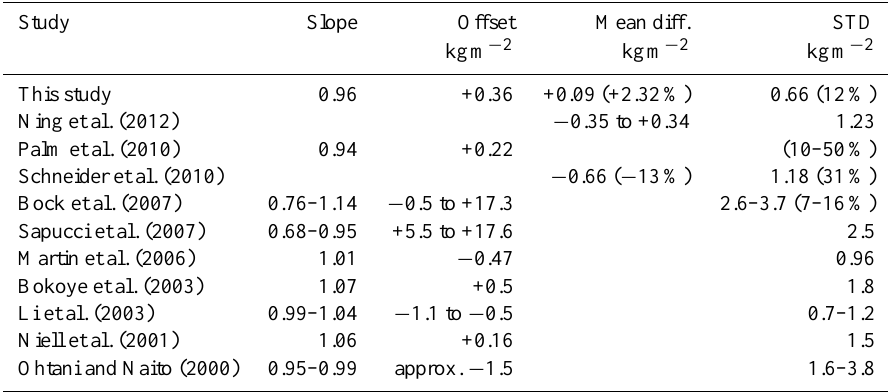
Table 6. GPS versus radiosonde (RS) result summary. Slope and offset of the linear fit IWV GPS = slope · IWV RS + offset are given where available, otherwise the mean difference (with relative value in parenthesis) is given. STD is the standard deviation of the absolute difference (with standard deviation of relative difference in